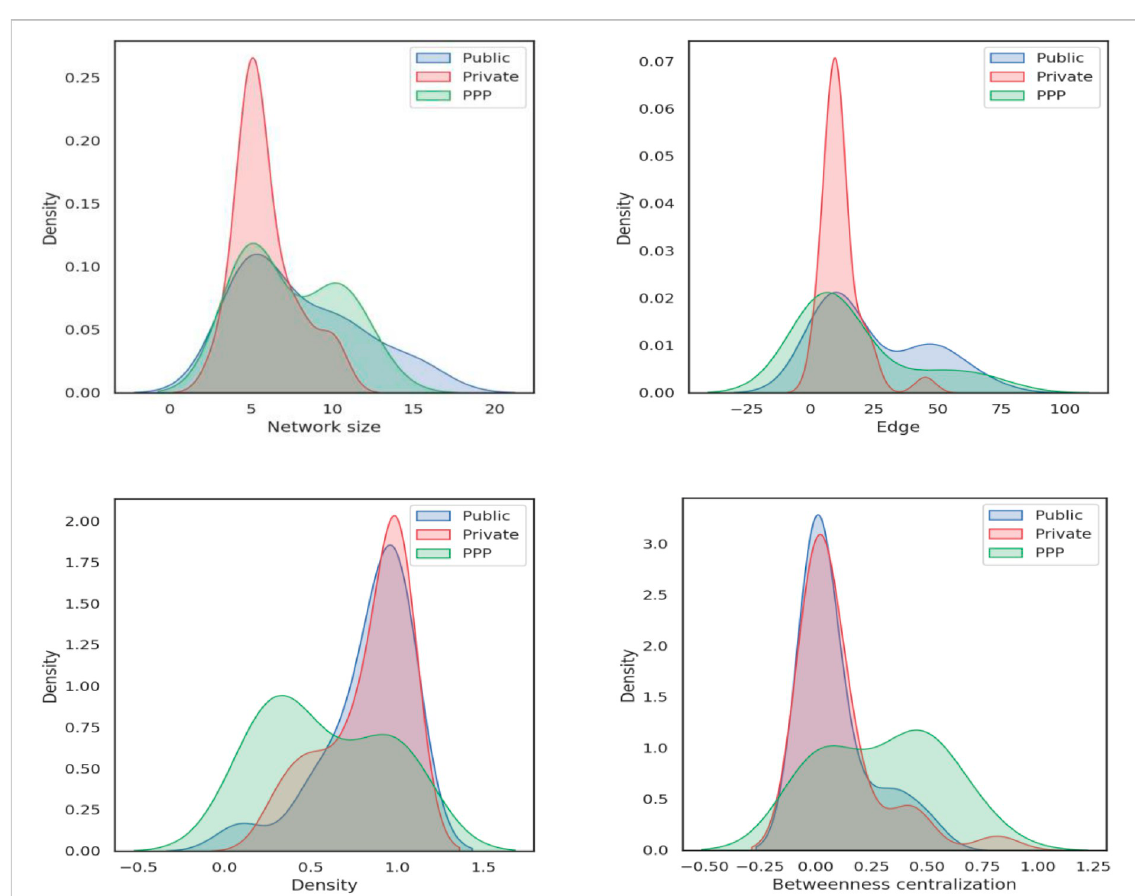
Fig 6. The kernel density estimations of four network